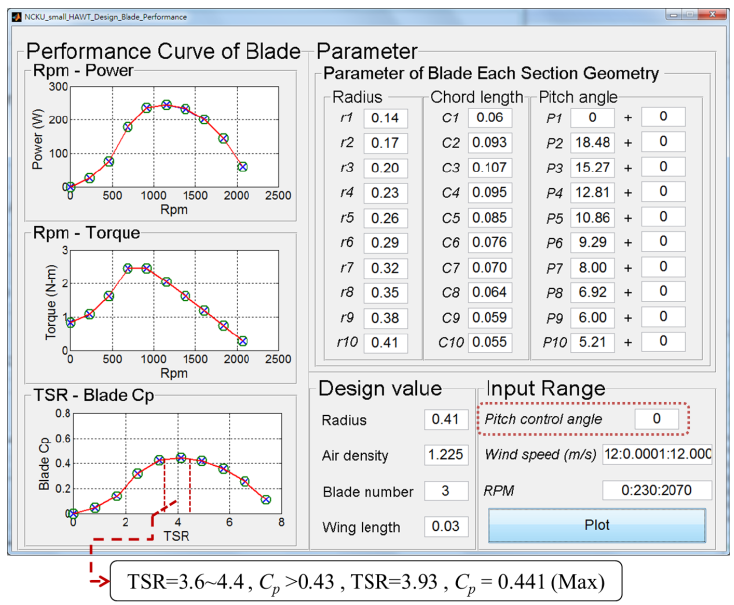
Figure 6. The performance curve of blade predicted by HAWT-Perform.